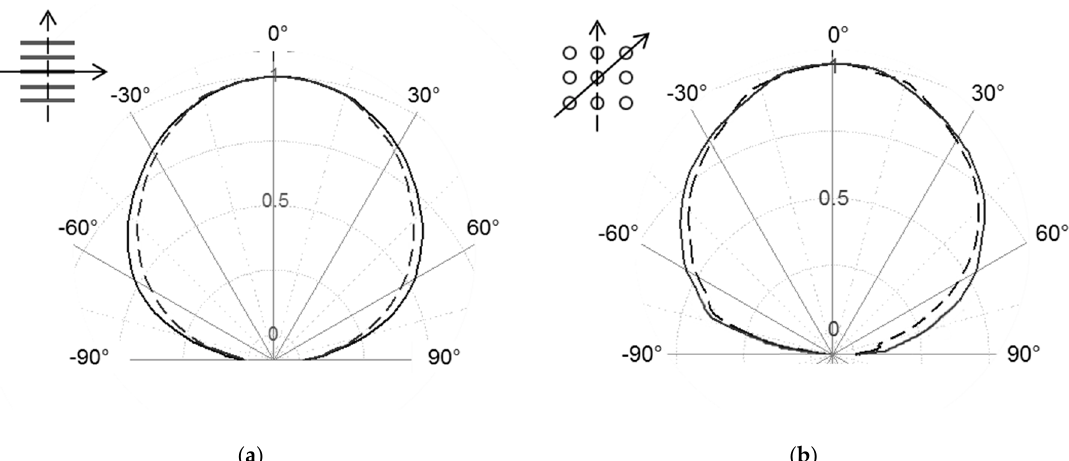
Figure 6. ( a ) Comparison of radiation pattern diagram of LED with 1D PhC and ( b ) 2D PhC measured at two di ff erent directions. Table 1. Di ff raction extremes for 1D and 2D PhC structure calculated for di ff erent directions and for first three di ff raction orders. Direction 45 ◦ corresponds to diagonal of square